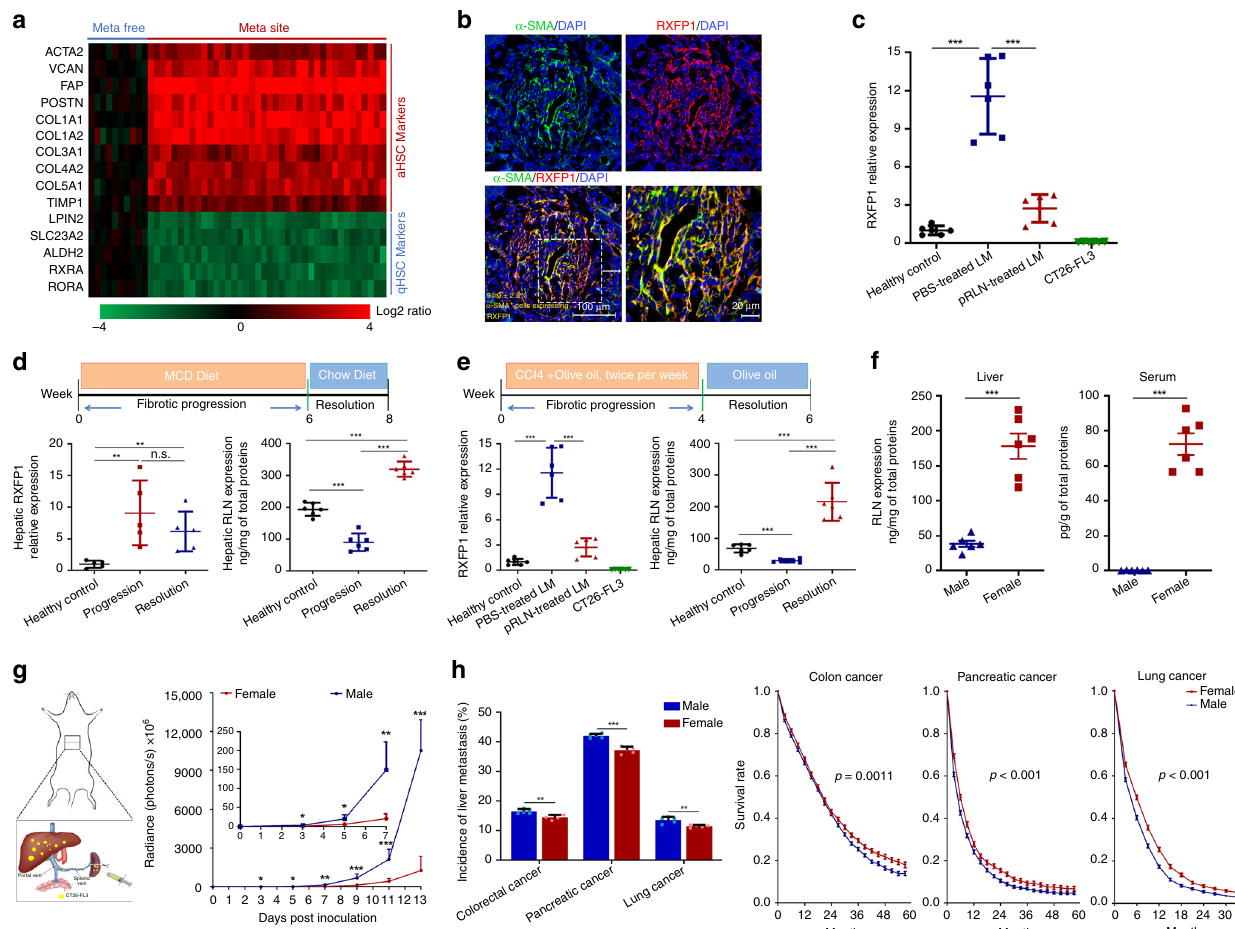
Fig. 1 HSC activation in liver metastasis and an endogenous regulation mechanism. a Heat map comparing activated and quiescent HSC (aHSC and qHSC) gene signatures between metastatic-free sites and metastatic sites in CRC liver metastasis patients. Columns represent 50 GEO patient samples grouped according to different collection sites (metastasis-free (meta-free) and metastatic site (meta site)); rows represent HSC markers sorted by different states (activation and quiescence). Values represent the log2 ratio over control (gene expression in metastasis-free samples). b Expression of RXFP1 on aHSCs in the CT26-FL3 metastatic liver. Numbers in yellow indicate the average % of α -SMA-positive cells expressing RXFP1 quanti fi ed in fi ve randomly selected fi elds per mouse ( n = 3). Bars in lower left and right panels represent 100 and 20 μ m, respectively. c Relative RXFP1 expression in CT26-FL3 metastatic livers of PBS and pRLN LCP-treated groups as well as in CT26-FL3 cell lines were compared with healthy livers by quantitative RT-PCR ( n = 6). LM liver metastasis. d , e Hepatic RXFP1 and RLN expression at different stages of MCD diet-induced NASH model ( d ) or CCl 4 -induced liver fi brosis ( e ). Relative RXFP1 mRNA and RLN peptide expressions in the fi brotic livers at different stages were compared with healthy livers by quantitative RT-PCR ( n = 5) and ELISA ( n = 6), separately. f RLN peptide expression in the liver and serum of male and female mice bearing CT26-FL3 liver metastasis ( n = 6). g Schematic of CRC liver metastasis model via hemi-splenic injection and gender disparity of the metastatic progression monitored by bioluminescence analysis ( n = 5). h Differences of the incidence and survival of synchronous liver metastases from CRC (4898 males vs. 3460 females), pancreatic cancer (2708 males vs. 1718 females), and lung cancer (3001 males vs. 2256 females) in male and female patients aged 15 – 60 based on the clinical data (2010 – 2014) acquired from SEER database. Signi fi cant differences were assessed in ( c − g ) (each time points), and ( h ) left panel using t test, in ( h ) right panels using log rank test. Results are presented as mean (SD). * p < 0.05, ** p < 0.01, *** p < 0.001, n.s., not signi fi